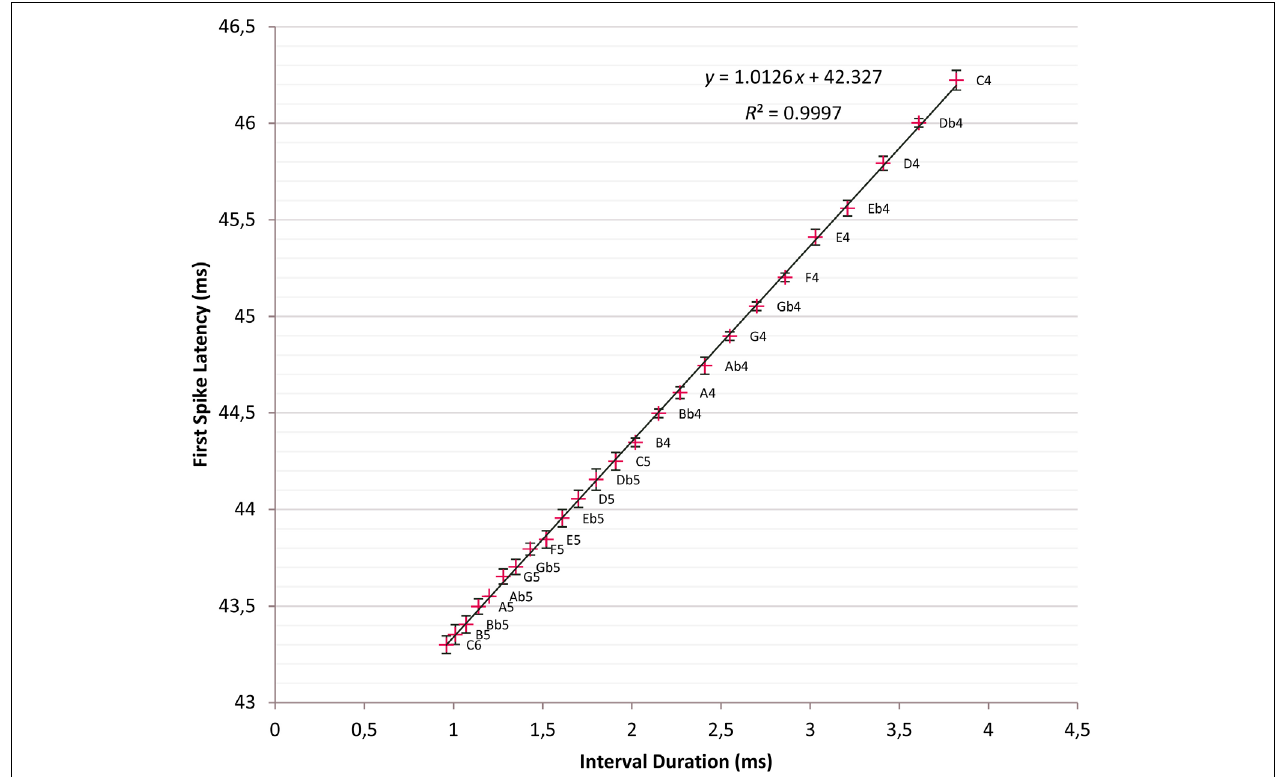
FIGURE 5 | Time intervals versus first spike latencies (FSLs). Crosses: Tone intervals and corresponding FSLs; t = 5 ms; linear regression line fitted: y = 1.0126 x + 42.327, R 2 = 0.9997; error bars ± 2 σ ; 95% confidence